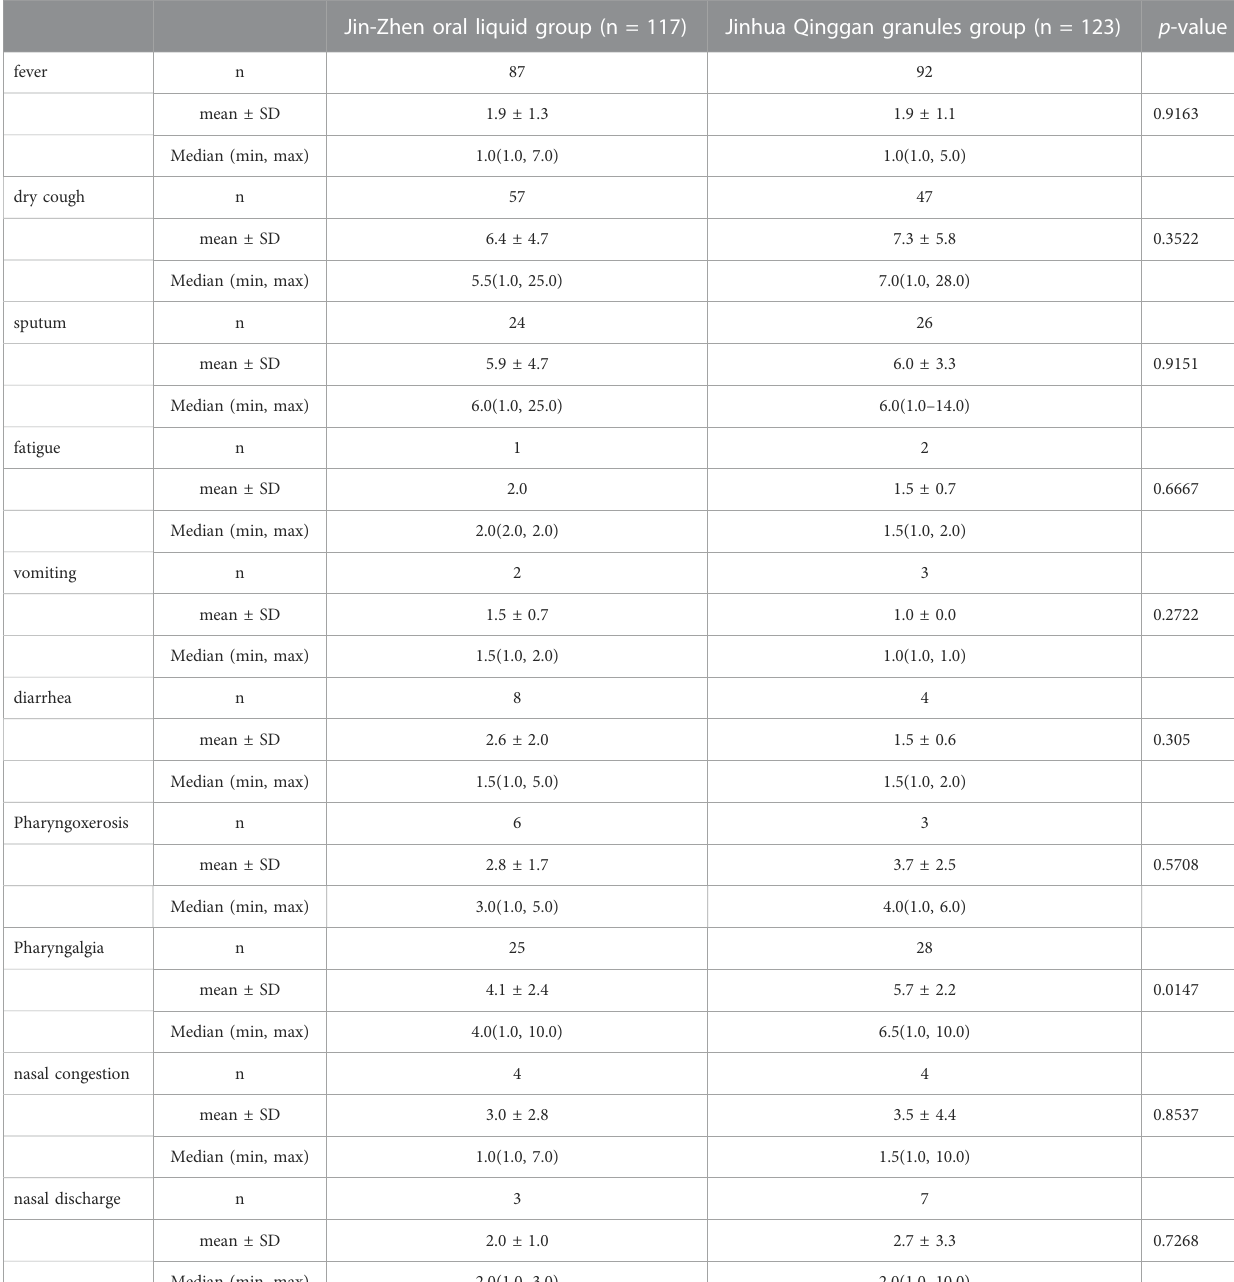
TABLE 3 The time to disappearance of major clinical symptoms in the two groups after treatment